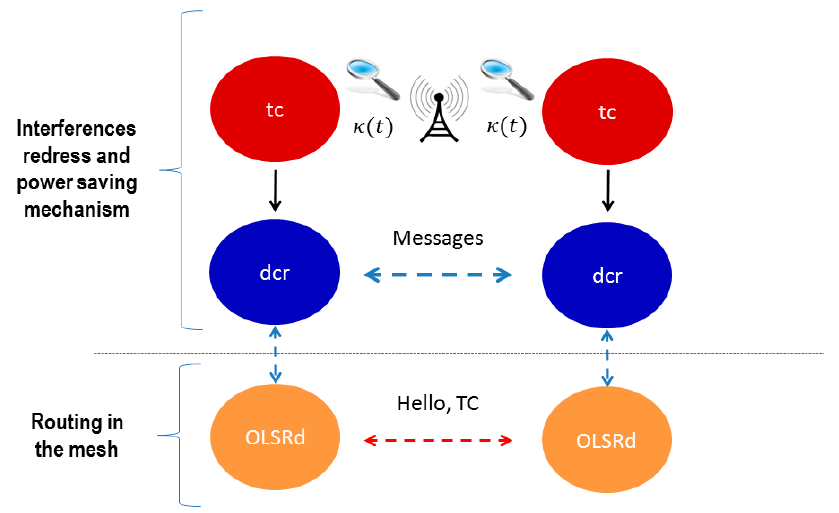
Figure 5. Block diagram for our proposal. Table 3. List of messages the MAPs manage to set its wireless interface orderly